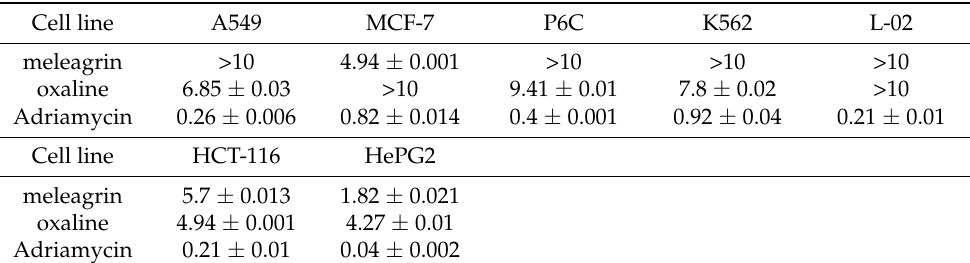
Table 2. Cytotoxicities of meleagrin and oxaline (IC 50 , µ Table2. Cytotoxicities of meleagrin and oxaline (IC 50 , μ M).